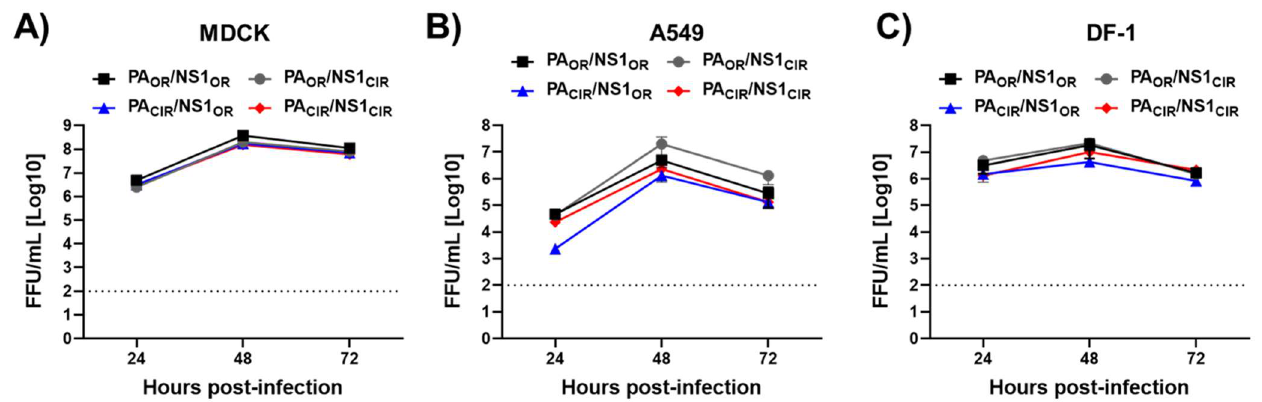
Figure 5. Growth kinetics of recombinant viruses containing amino acid changes in H5N1 IAV NS1 and PA proteins: MDCK ( A ), A549 ( B ), or DF-1 ( C ) cells were infected (MOI of 0.001 for MDCK or 0.01 for A549 and DF-1) in triplicates with the recombinant viruses encoding the indicated H5N1 NS1 and PA proteins (PA OR /NS1 OR , PA OR /NS1 CIR , PA CIR /NS1 OR , and PA CIR /NS1 CIR ). Virus titers in cell culture supernatants were determined at the indicated h p.i. by immunofocus assay (FFU/mL). No statistically significant differences among PA OR /NS1 OR vs. PA OR /NS1 CIR , PA CIR /NS1 OR , or PA CIR /NS1 CIR , using 2-way ANOVA ( p < 0.001), were found.